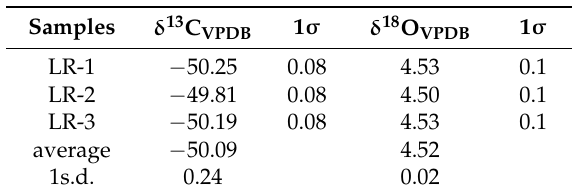
Table 3. Stable isotope